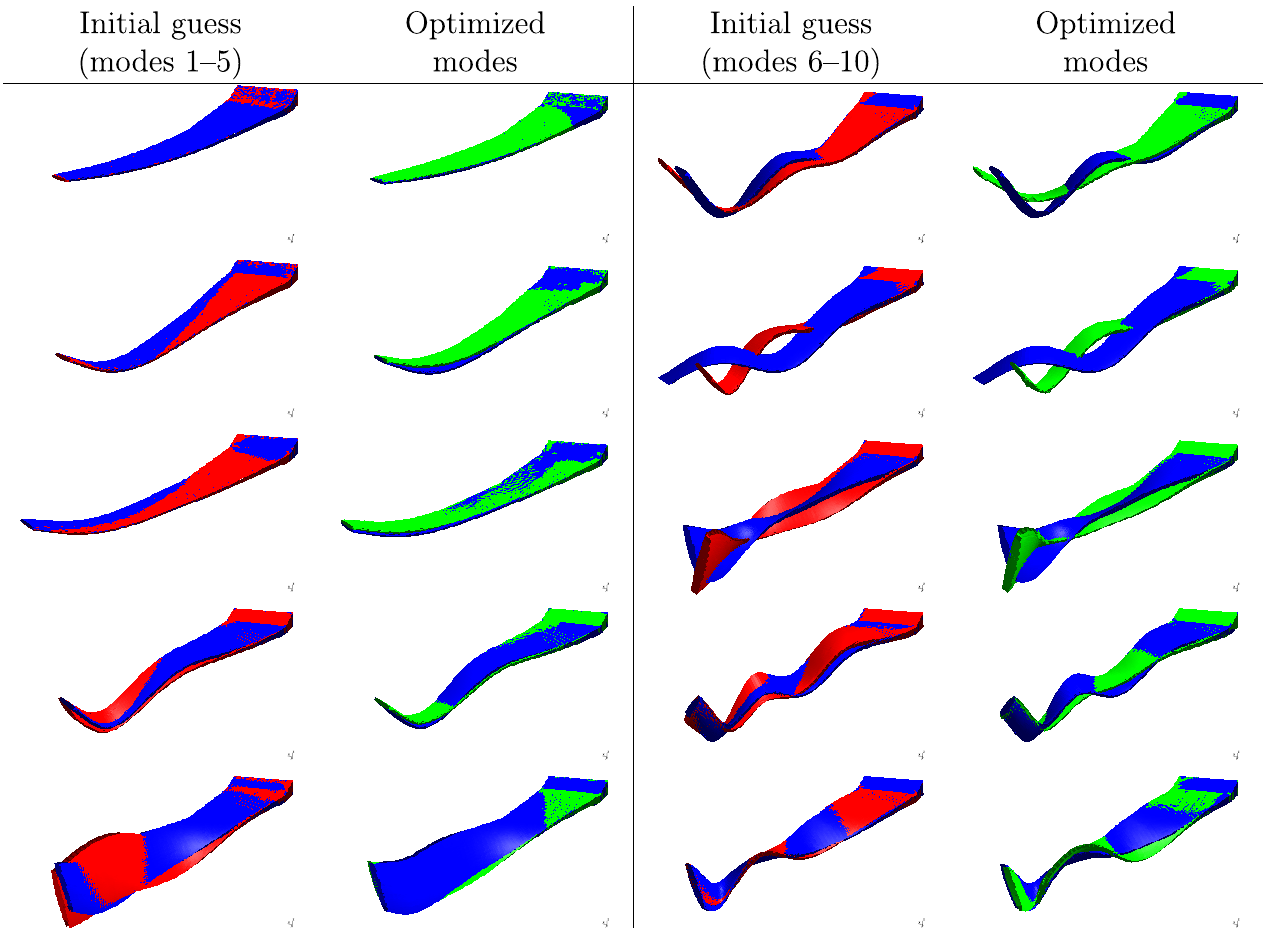
Fig. 7. Modal results of the first optimization iteration overlapped with the reference ones for N = 10